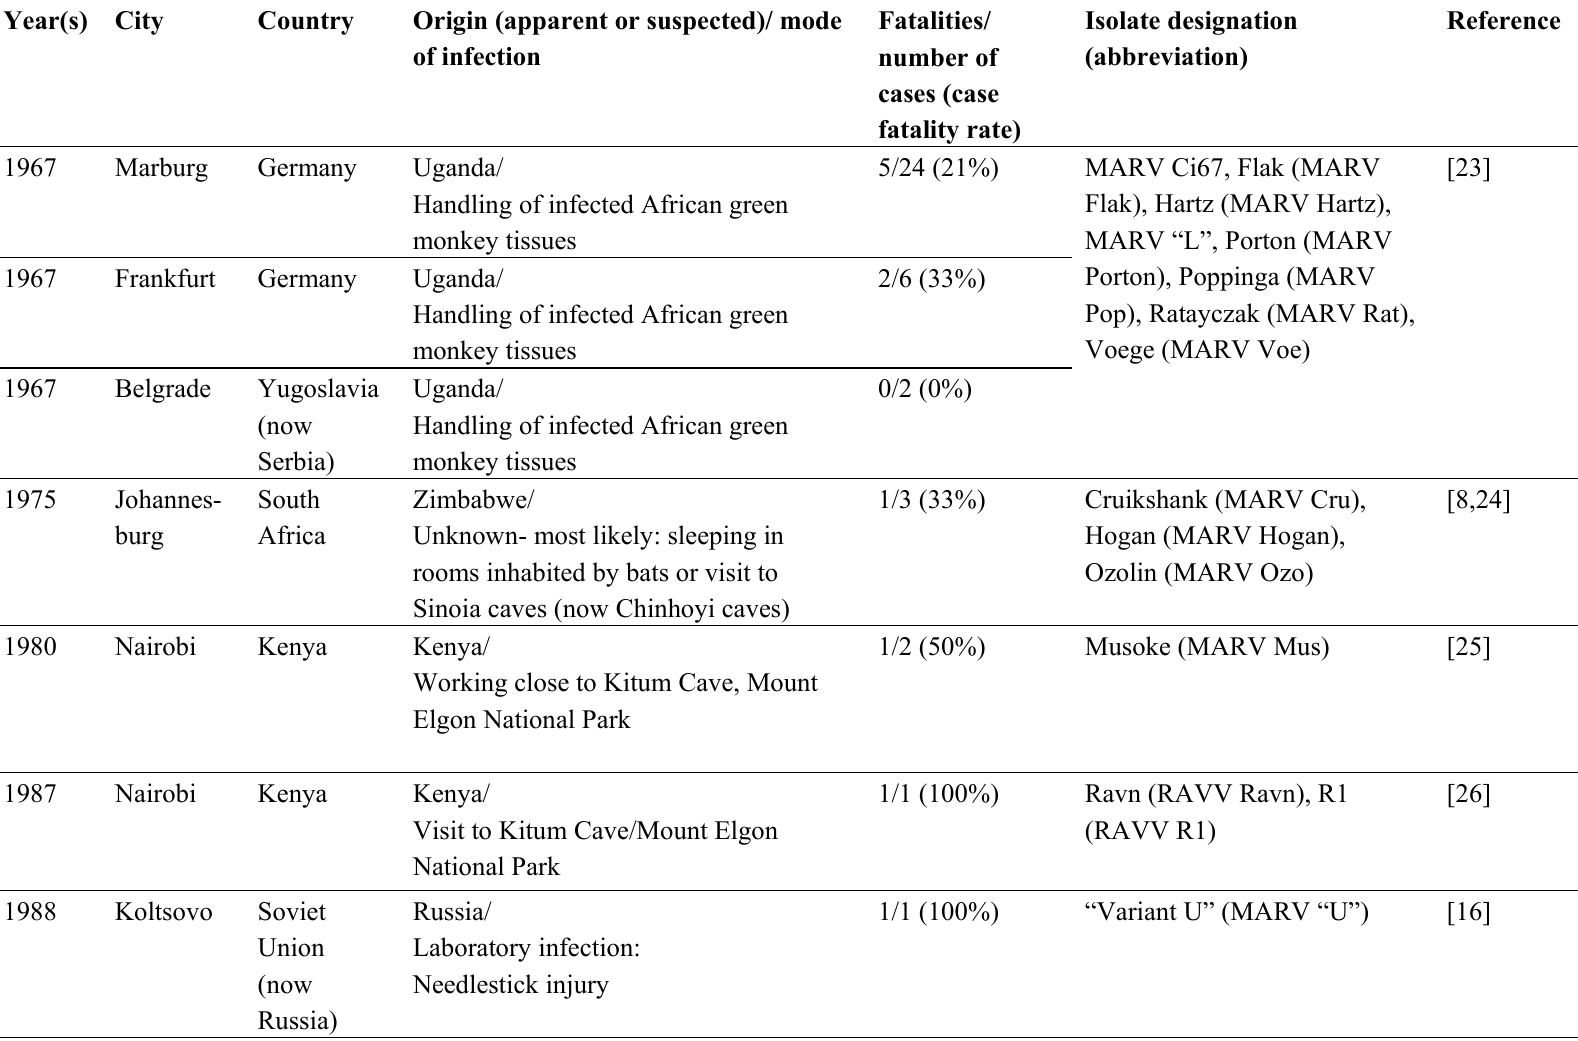
Table 1. Marburg virus disease outbreaks. History of all laboratory confirmed MVD cases. Table modified from